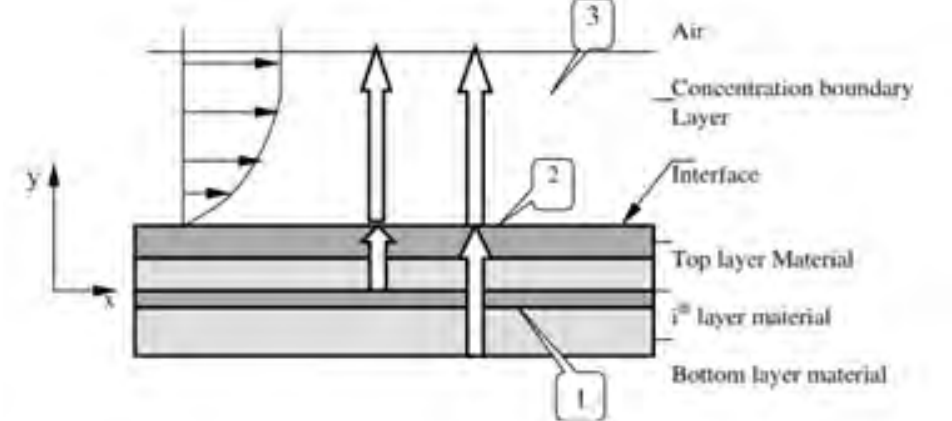
Figure 2. Physical configuration of VOC emissions from a multi-layer material. (1) Internal diffusion; (2) desorption; and (3) external convection and diffusion (Haghighat & Huang, 2003).